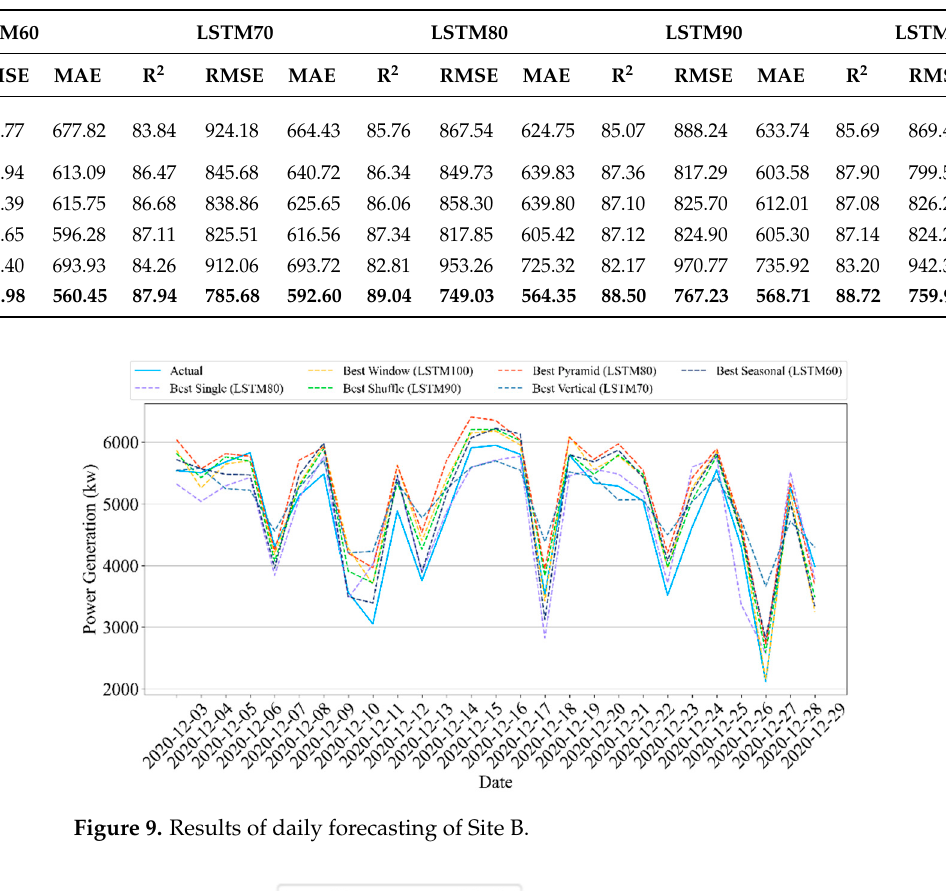
Table 9. Experimental results of daily forecasting of Site B.